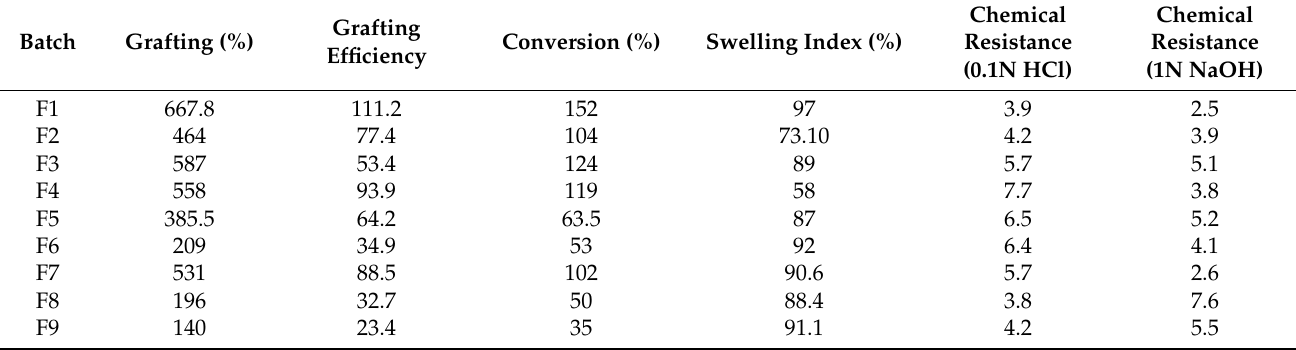
Table 2. Various evaluation data of grafted tamarind seed polymer